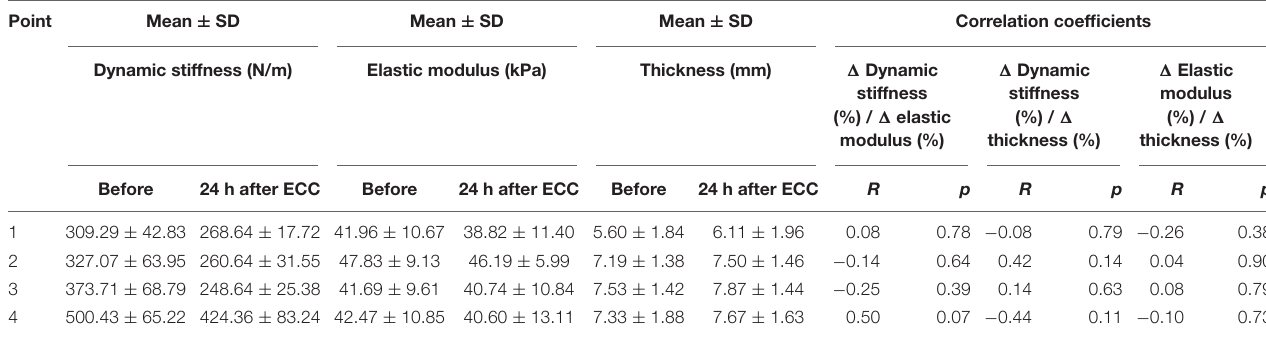
Point Mean ± SD Mean ± SD Mean ± SD Correlation coefficients Dynamic stiffness